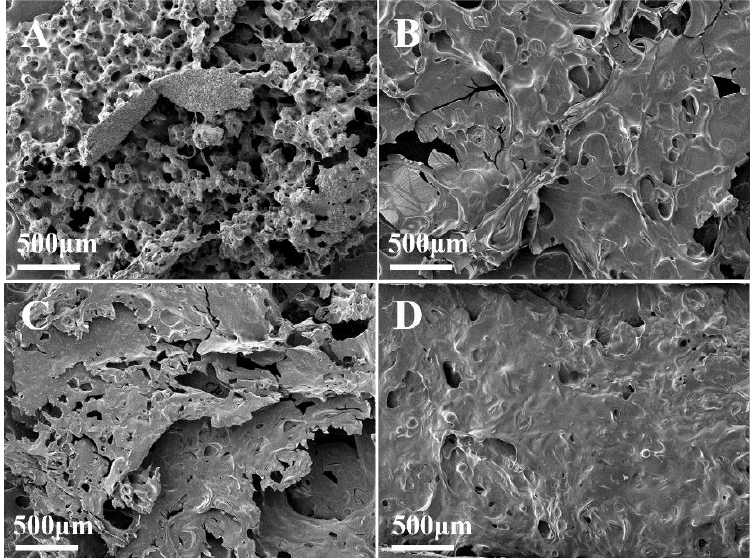
Figure 11. SEM image of char layer of epoxy resin composite. ( A ) EP/MMT, ( B ) EP/DOPO, ( C ) EP/DOPO + MMT, ( D ) EP/DOPO-MMT. ( C ) EP/DOPO+MMT, ( D )